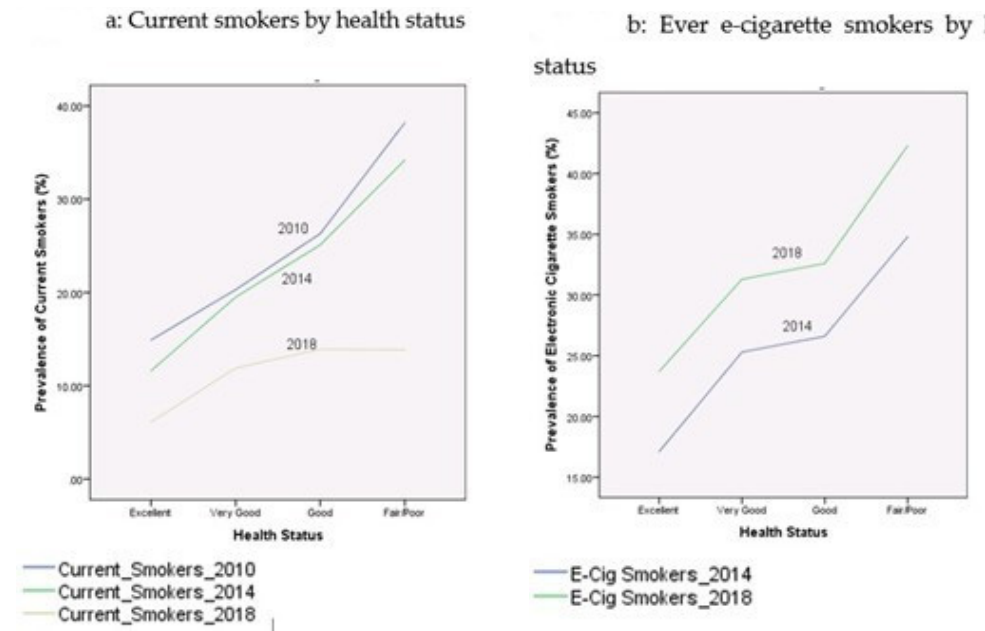
Figure 5. Prevalence of smoking behaviors by health status, NHIS 2010–2018.